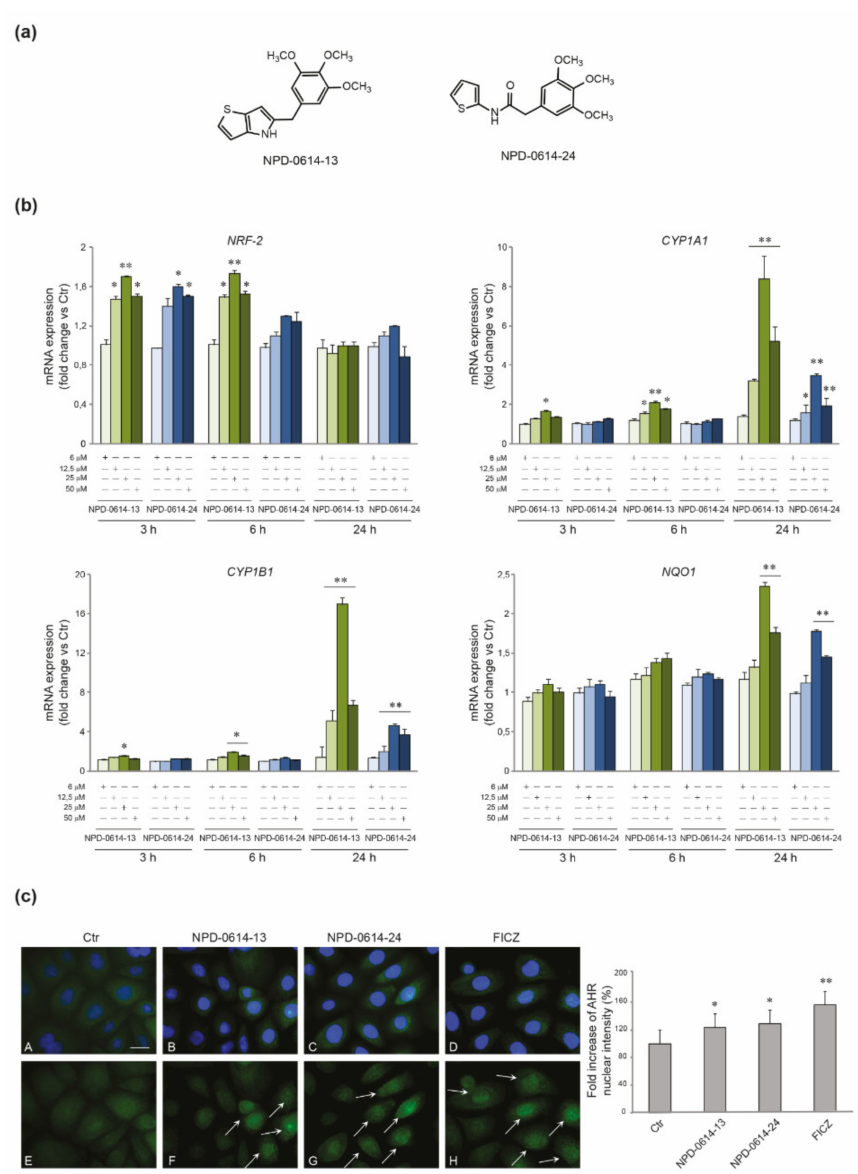
Figure 1. Activation of AhR signaling in response to NPD-0614-13 and NPD-0614-24 in